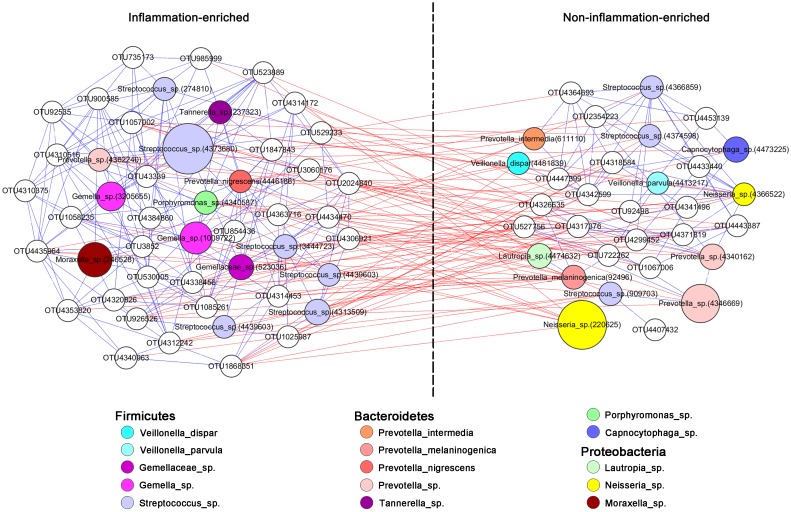
Pre-operative OTUs enriched in saliva samples of inflammation and non-inflammation subjects.Co-occurrence networks were constructed based on the relative abundance profiles of pre-operative OTUs differing between the inflammation and non-inflammation groups. Each node represents a different OTU, and the most abundant OTUs (relative abundance higher than 0.01%) are colored and annotated to indicate the species or unclassified species in a genus (sp.). The sizes of the nodes are proportional to the average relative abundances of the OTUs. Blue and red edges between each pair of OTUs indicate significantly positive and negative correlations, respectively (Spearman’s correlation coefficient > 0.4 or < -0.4, P < 0.05).